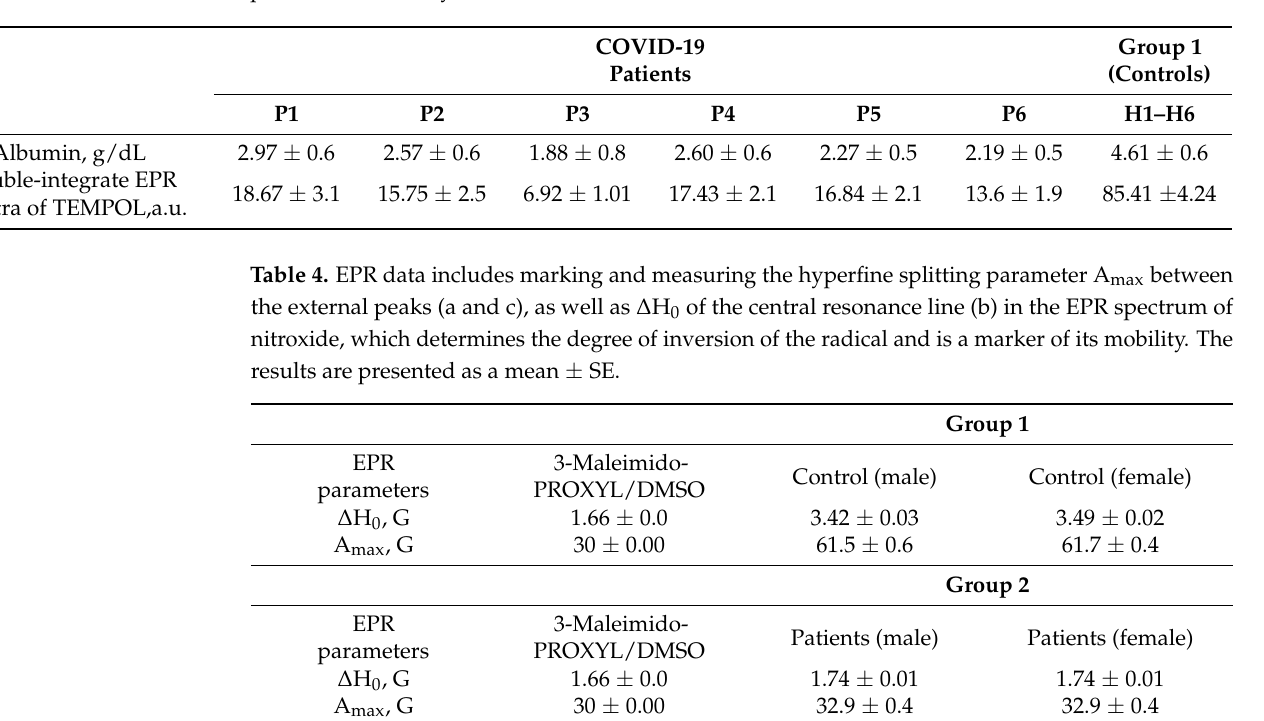
Table 3. Data of albumin levels (g/dL) and double-integrated EPR spectra (a.u.) in COVID-19 patients and healthy volunteers.